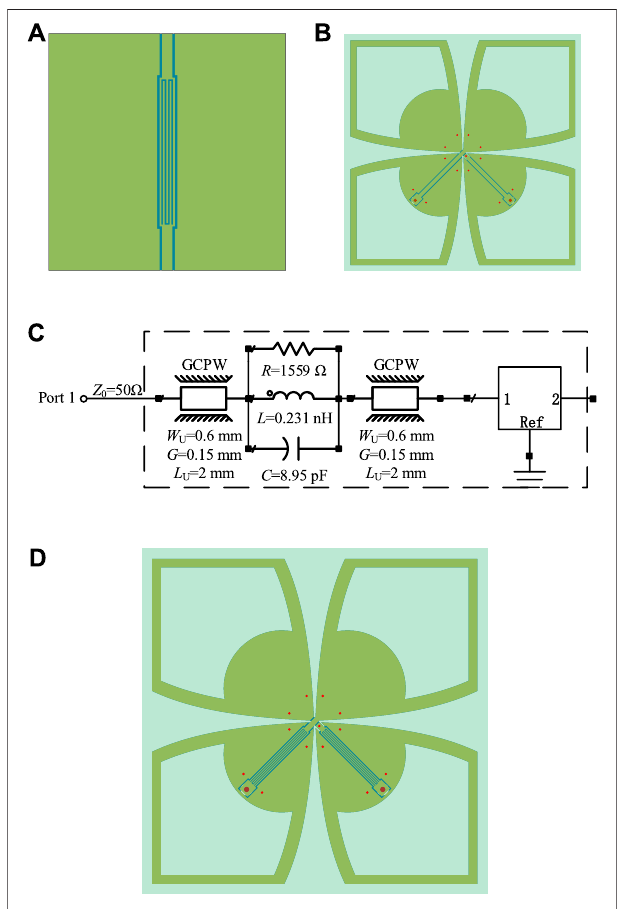
FIGURE 6 | (A) Proposed DMS resonator, (B) wideband antenna, and (C) the equivalent circuit when cascading these two parts. (D) Band-notched antennawiththeDMS resonator embedded into theGCPW feedinglineofthe wideband antenna.